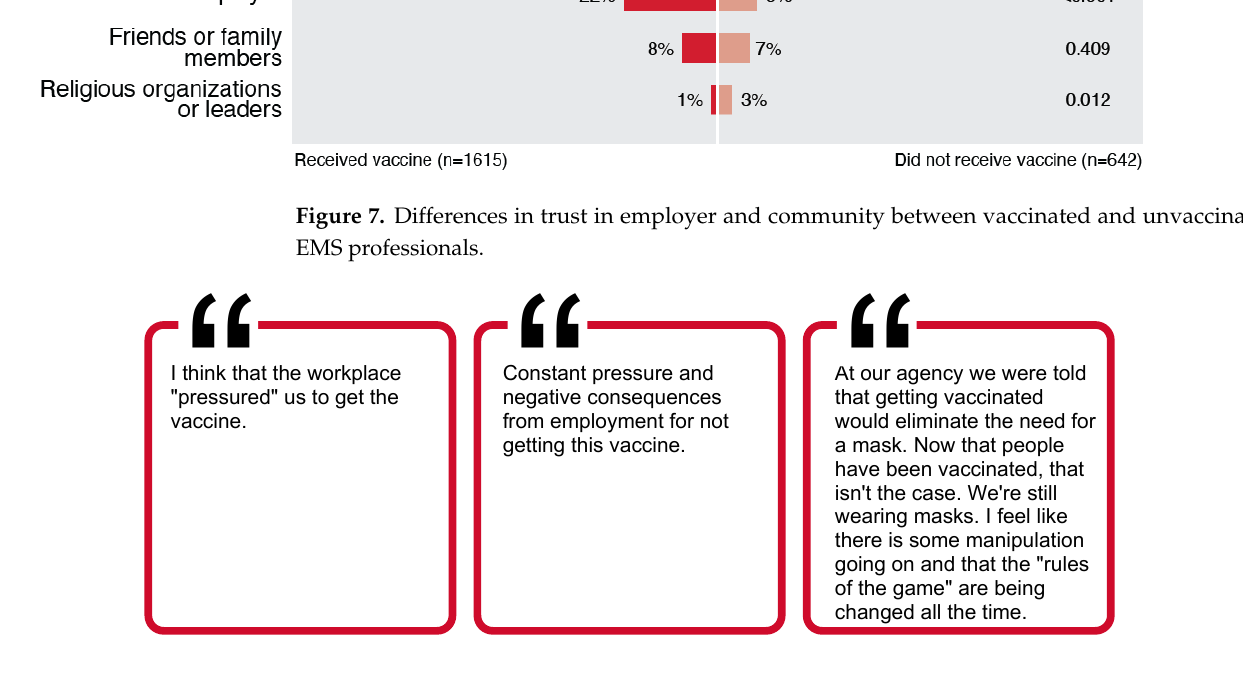
Figure 9. Differences in trust in no sources between vaccinated and unvaccinated EMS profession- als. 3.6. Additional Noteworthy Themes 3.6.1. Some Individuals Trust in Other Options to Manage COVID-19 Rather than the Vaccine While not related to trust in information sources—and generally not indicating where their information came from—many participants indicated they trusted things other than the vaccine to get them through COVID-19 (Figure 10). Such sources included God, one’s own immune system or current health status, the high survival rate among those who contracted COVID-19, antibodies from prior infection, and medication—both medications shown to be effective for the treatment of COVID-19 (e.g., Remedesivir) [24] and those that are not (e.g., hydroxychloroquine). Other comments suggested skepticism related to having had multiple COVID-19 exposures over the course of the pandemic yet not acquiring the disease themselves.